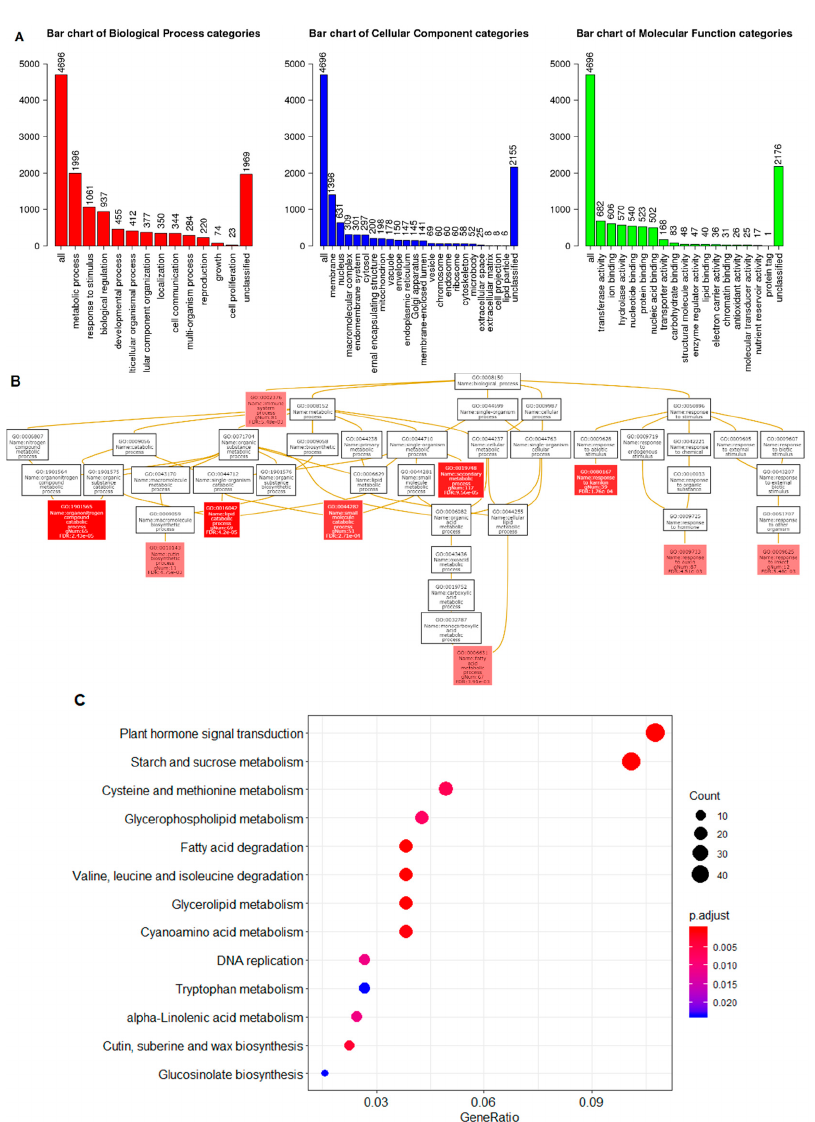
Figure 5. Functional enrichment of ScCBL6-regulated DEGs . ( A ) Summary of Gene Ontology (GO) annotation classified into three principal categories. ( B ) Directed acyclic graph of GO enrichment of DEGs. The colors in different boxes indicate significant level of FDR. ( C ) Kyoto Encyclopedia of Genes and Genomes pathway enrichment of DEGs against the Arabidopsis background set in clusterProfiler.